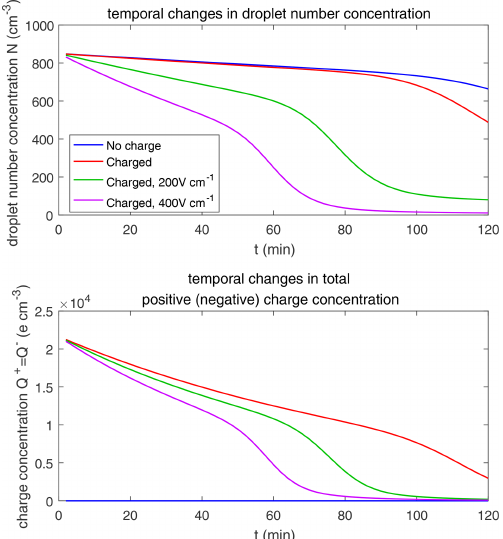
Figure 15. Temporal changes in droplet total number concentration and total charge content for ¯ r = 6 .